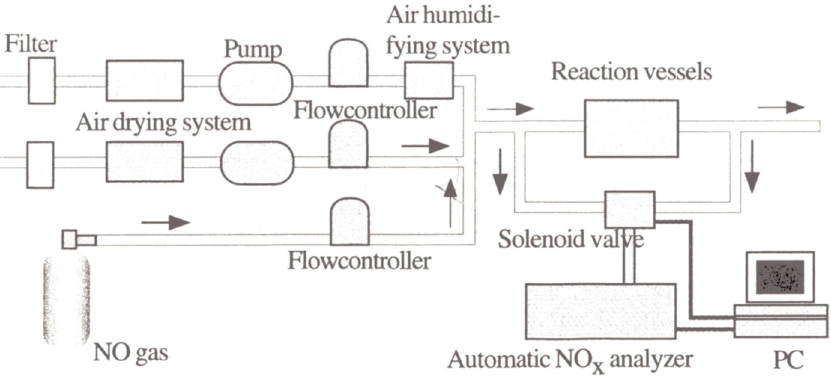
Figure 31. Indoor flow-through PVC reactor system for evaluating the performance of a brick in removing NO x from the environment. Simulated emission gas consisted of mixing dry air, dilute NO gas (1.0 ppm); flow rate was 3 L min − 1 ; air space between the brick and the Pyrex glass window was 5 mm; temperature, 25 ◦ C; relative humidity RH, 50%; UV intensity from 2 black lights (300–400 nm), 6 W m − 2 . Reproduced from Murata et al.